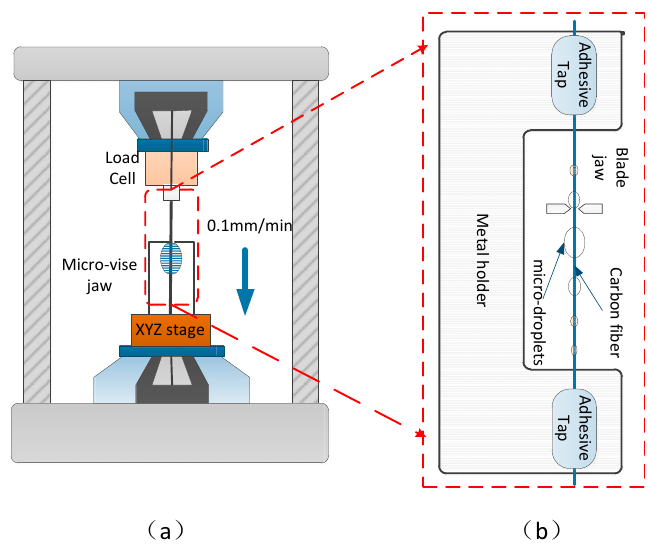
Figure 3. Details of microdroplet test: ( a ) Schematic of microdroplet experimental platform; ( b ) single fiber specimen for microdroplet testing.